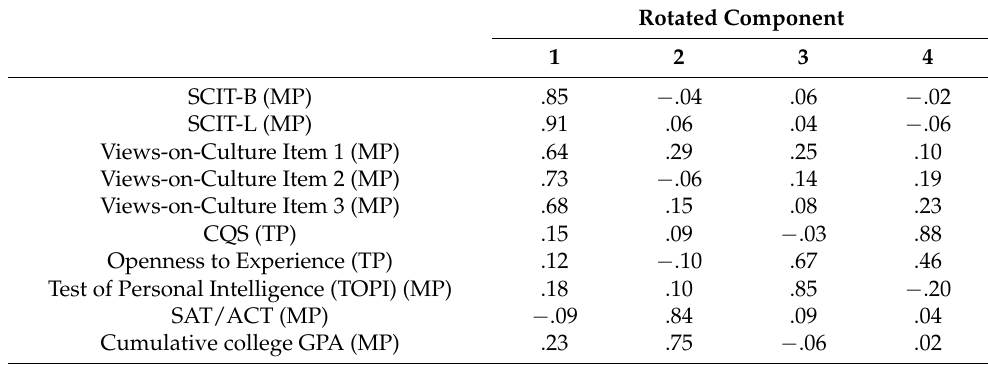
Table 8. Rotated Principal Components Matrix a : Sternberg Cultural Intelligence Tests SCIT Business (SCIT-B) and Leisure (SCIT-L), Views-on-Culture; Cultural Intelligence Scale (CQS), Openness